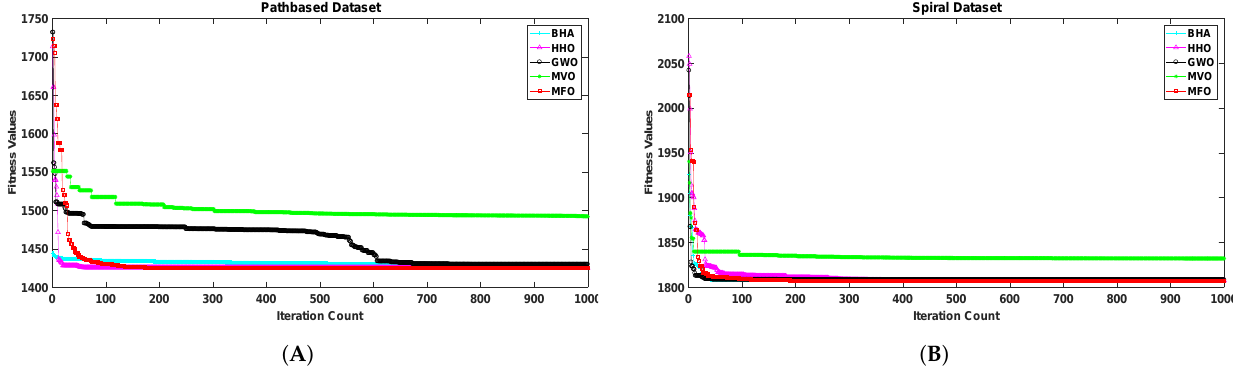
Figure 3. Variation in the best fitness values of algorithms for datasets ( A ): Aggregation, ( B ): Compound with respect to iterations.